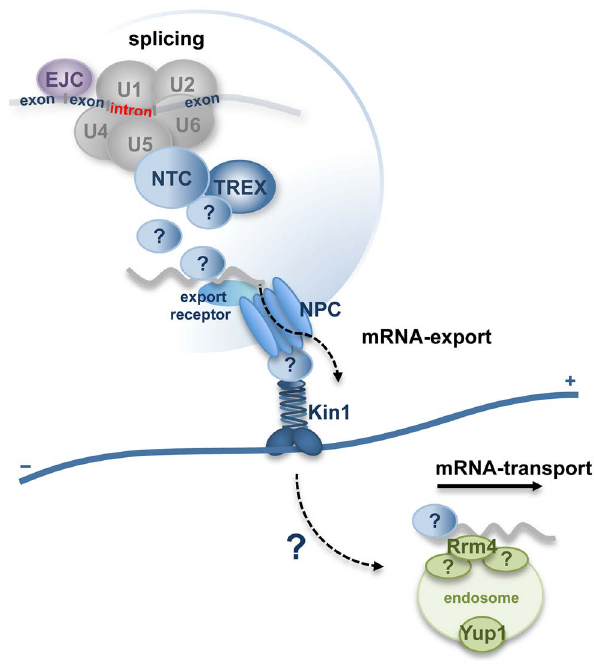
Figure 8. Hypothetical model for function of Num1 coordinat- ing pre-mRNA splicing with nuclear pore complex-dependent export of mRNP-particles and microtubule-based mRNA-trans- port. Num1 is a component of the spliceosome-associated Prp19/ CDC5L-complex (NTC) and has a global effect on splicing efficiency. NTC-components interact with the TREX (‘‘transcription-coupled export’’)-complex [82], which mediates the export of mature transcripts into the cytoplasm via the nuclear pore complex (NPC) [83–86]. Adapter proteins connect the mRNA to NPC-bound export receptors. The Kinesin-1 motor protein has been shown to be associated to the NPC and promotes nucleo-cytoplasmic transport processes [76]. mRNAs within the hyphae are distributed via the RNA-binding protein